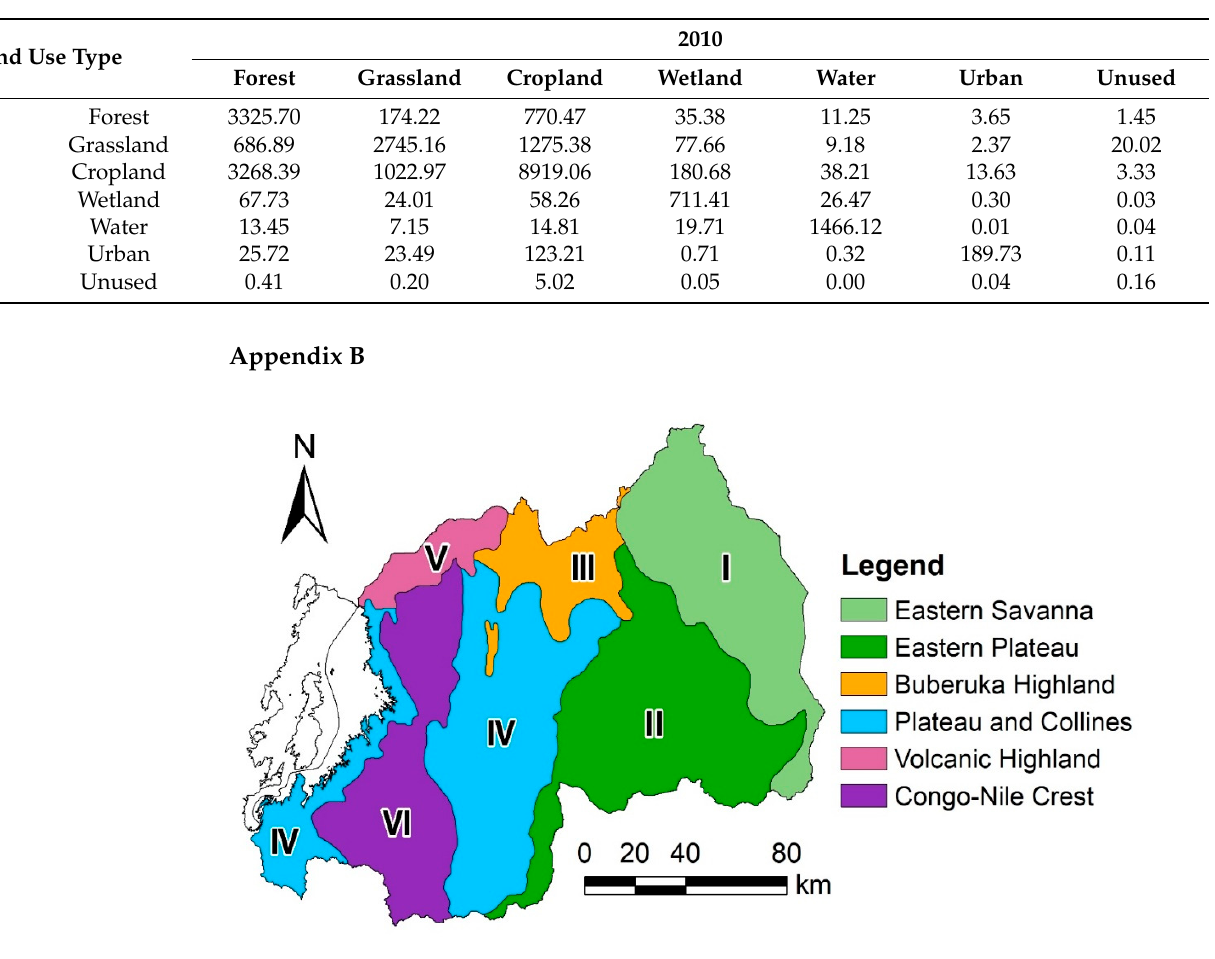
Figure A1. Map of the six agro-ecological zones [53].